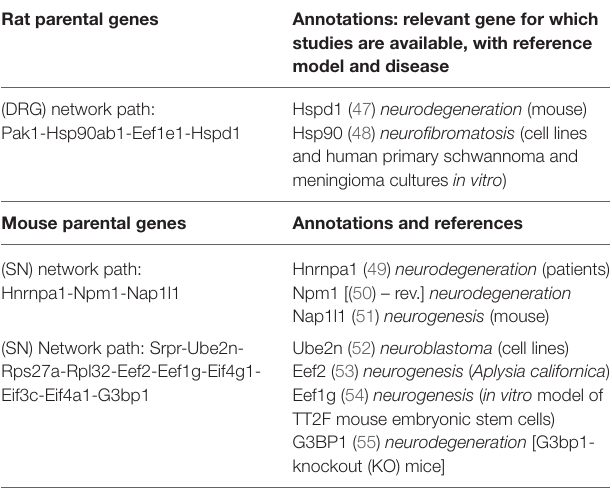
Network paths are visible in Figures 3 and 4 . A path between two nodes in the network is defined as a sequence of adjacent nodes to be traversed in order to go from one of the two nodes to the